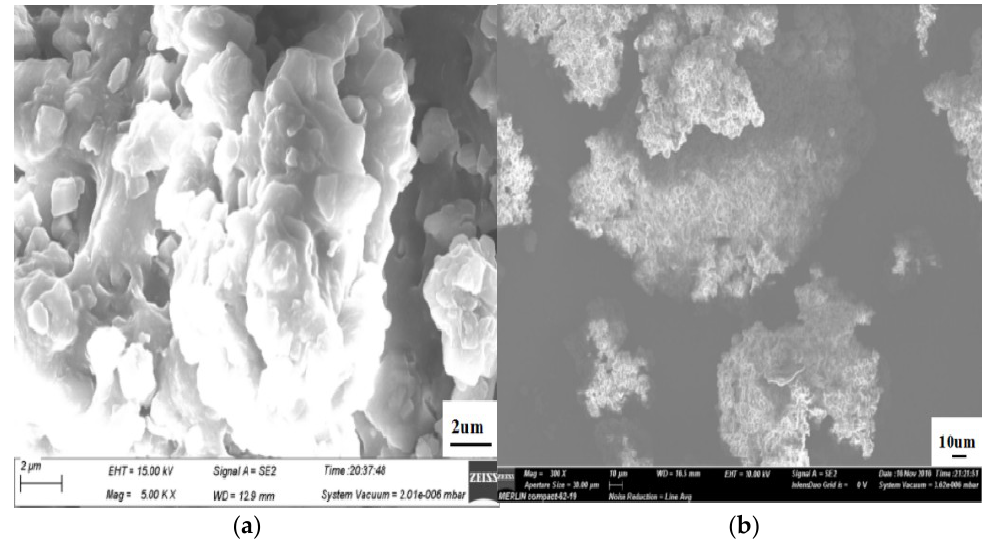
Figure 5. SEM images of silicone rubber powder. (a) 5000× magnification; (b) 300× magnification.